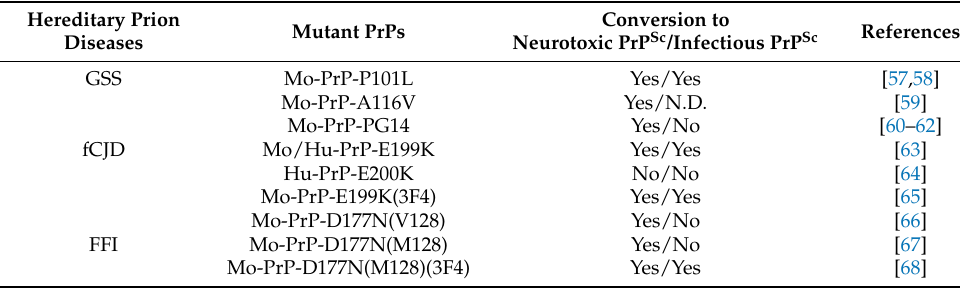
Table 1. Hereditary prion disease-associated mutations in PrP